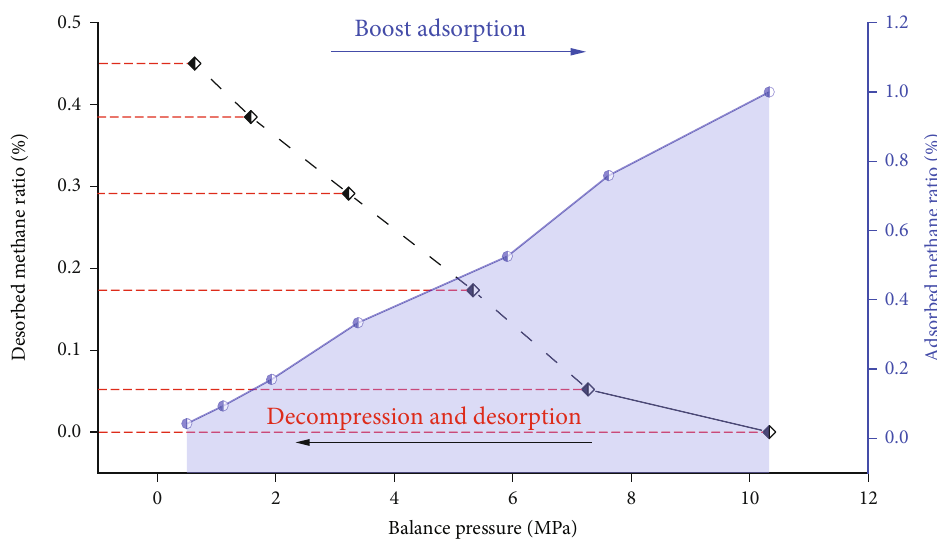
Figure 12: The proportion of methane in di ff erent